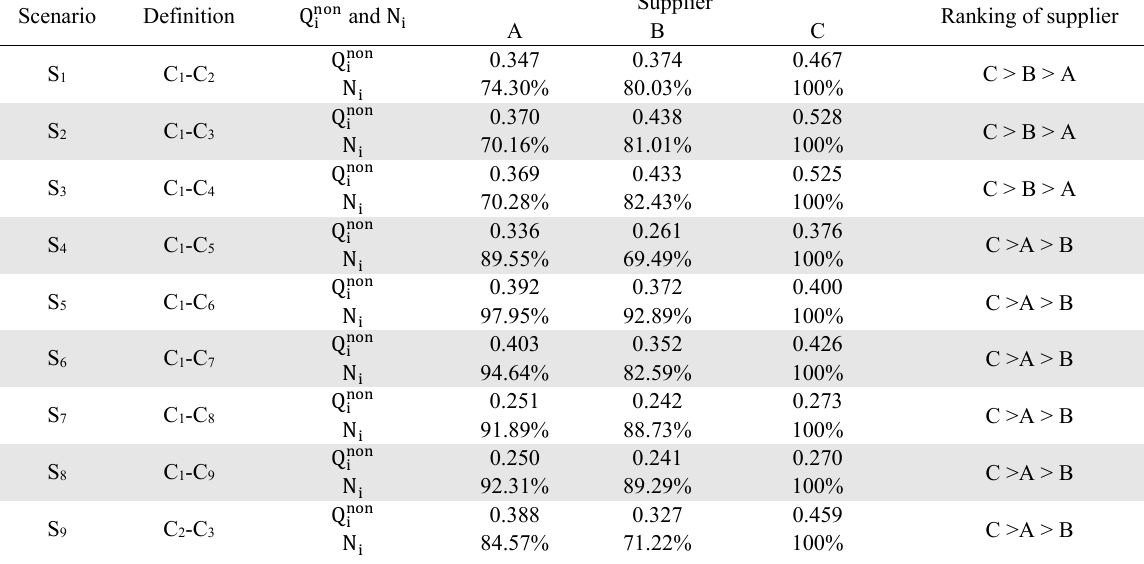
Sensitivity analysis of 36 scenarios